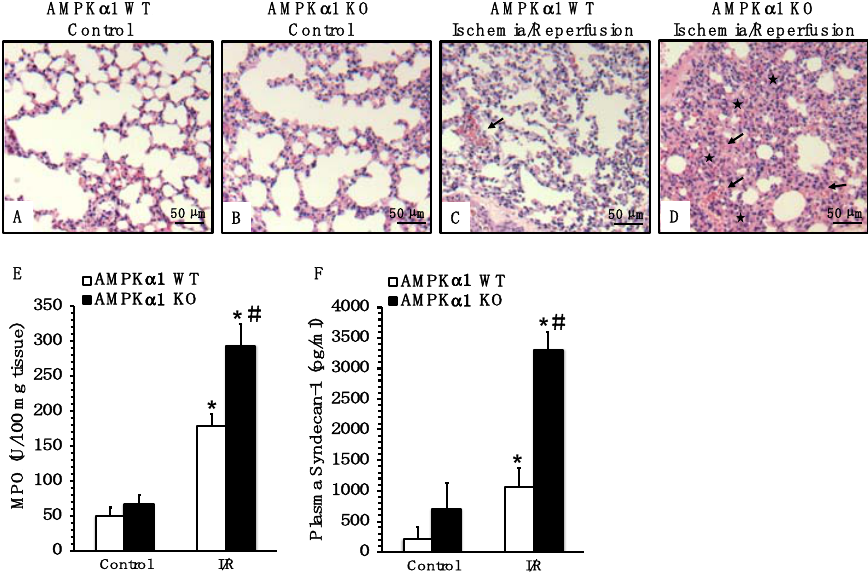
Figure 5. Effect of genetic deficiency of AMPK α 1 on lung injury and endothelial damage. ( A – D ) Representative histology photomicrographs of lung sections of AMPK α 1 WT and KO mice at 4 h after mesenteric ischemia and reperfusion (I/R). ( A ) Normal lung architecture in control WT and ( B ) control KO mice. ( C ) Moderate hemorrhage and inflammatory cell infiltration (arrow) in WT mice subjected to I/R injury. ( D ) Increased alveolar congestion (asterisks), hemorrhage and neutrophil infiltration (arrows) in KO mice subjected to I/R injury. Magnification ×100. A similar pattern was seen in n = 6 different tissue sections in each experimental group. ( E ) Lung neutrophil infiltration assay by myeloperoxidase (MPO). Data represent the mean ± SEM of 10 mice for each group. ( F ) Endothelial damage measurement by plasma levels of syndecan-1. Data represent the mean ± SEM of 4–10 mice for each group. * p < 0.05 versus control mice of the same genotype; # p < 0.05 versus WT group. Scale bar: 50 μ m.